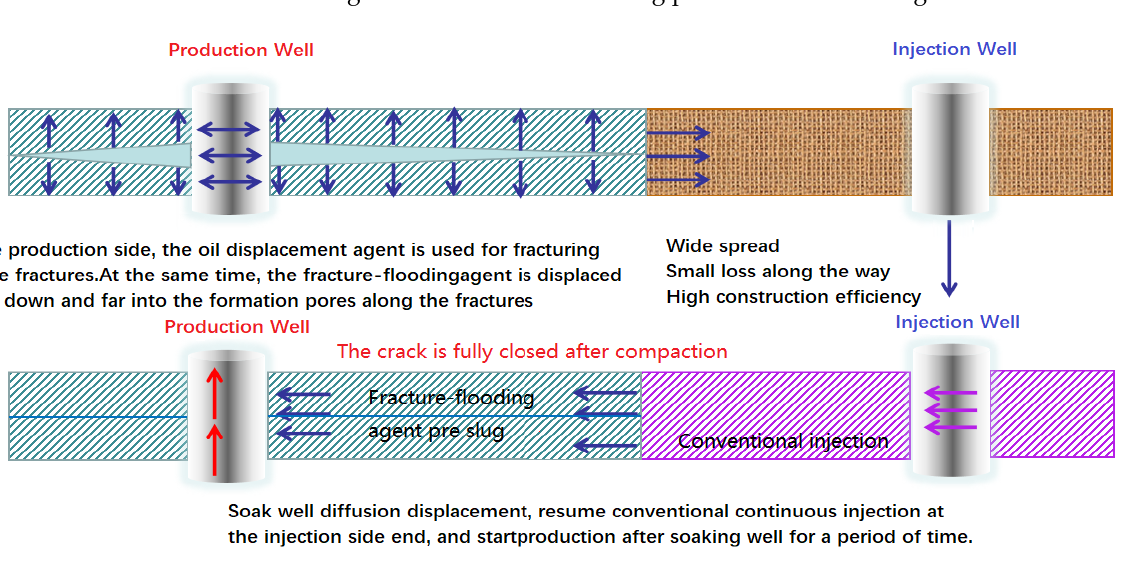
Figure 2. Schematic diagram of fracture flooding.